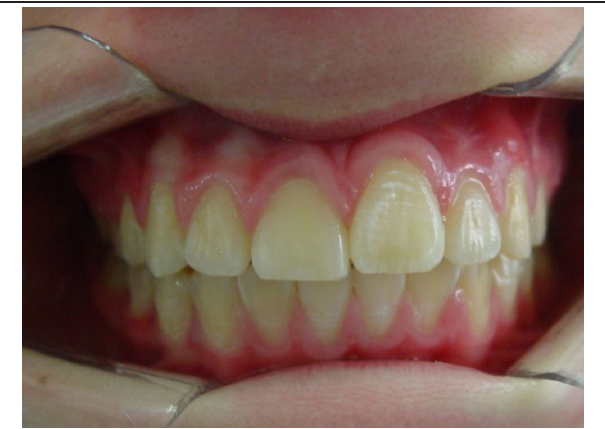
FIGURA 12 – Aspecto intraoral final DISCUSSÃO Estudos recentes demonstram que, entre os tumores odontogênicos, o odontoma é o segundo mais prevalente. Siriwardena et al . (2019) (11) e da Silva et al . (2018) (12) observaram essas lesões em 25,5% e 36,1% dos casos analisados, respectivamente. Esses tumores ficam atrás apenas dos